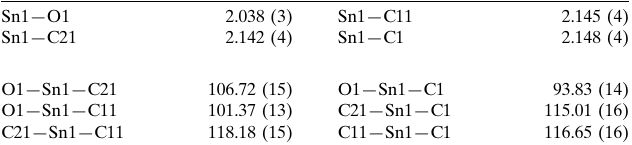
Selected geometric parameters (A˚ , (cid:1)